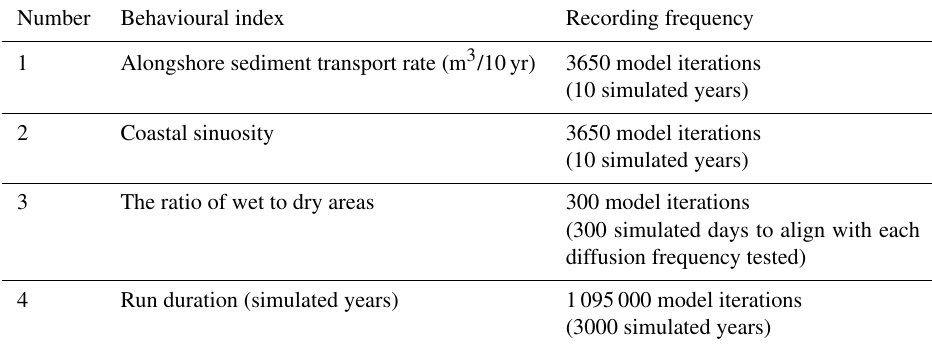
Table 2. A table showing the four behavioural indices used in the Morris method and the frequency that data are recorded in each simulation. Number Behavioural index Alongshore sediment transport rate (m 3 /10yr)